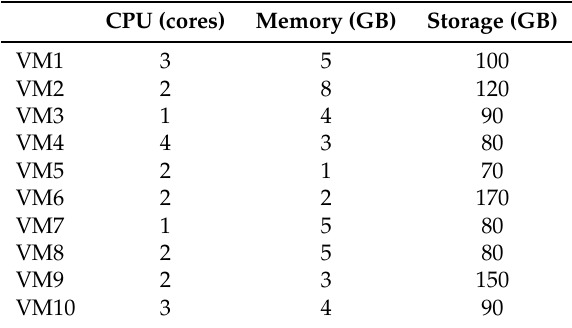
Table 1. Resources required by the